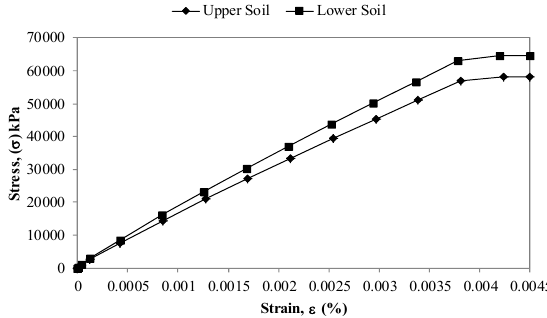
Fig. 11. The uniaxial compressive stress-strain relationship for foundation rock.